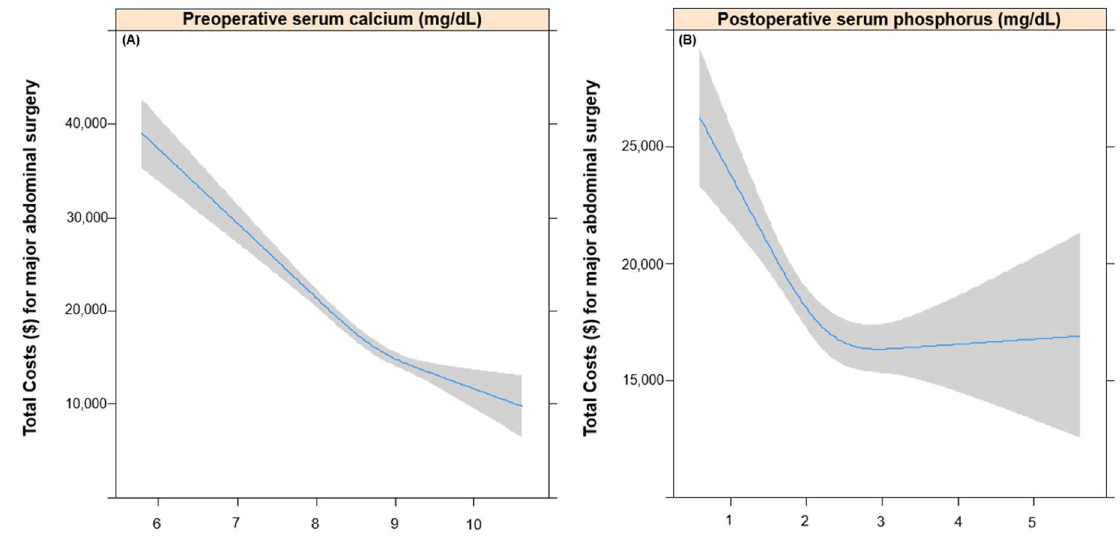
Figure 2. Relationship between total costs and preoperative calcium ( A ) and postoperative phosphorus ( B ).